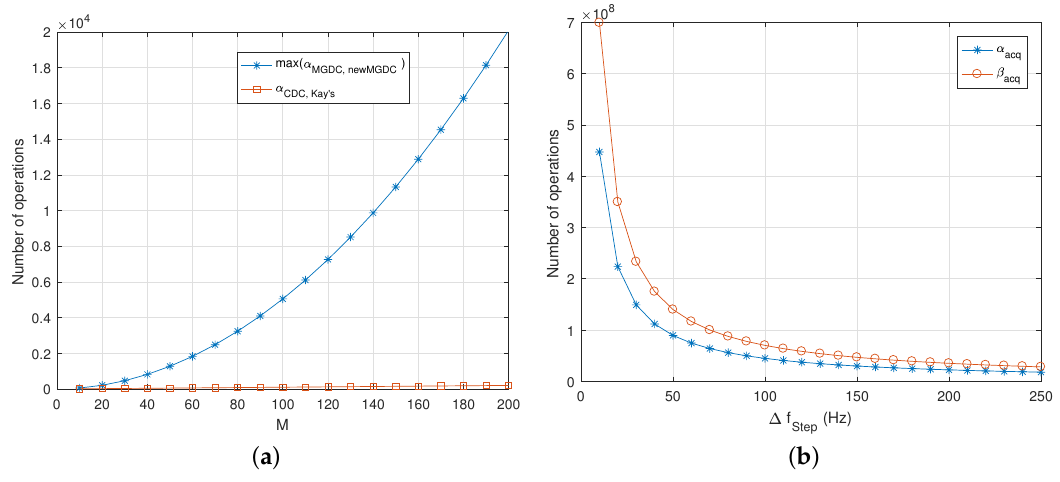
Figure 10. ( a ) maximum number of operations of the new MGDC method; ( b ) computational load of acquisition stage (or batch processor) at each interval using Fast Fourier Transform (FFT), F s = 4 MHz, T coh = 1 ms.